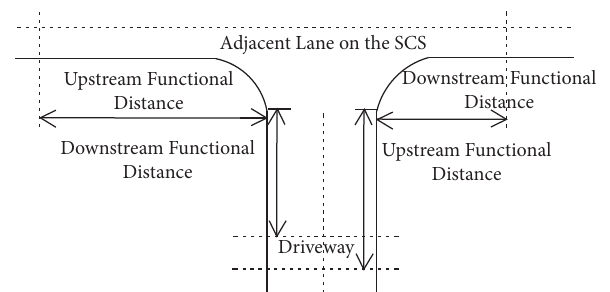
Figure 15: Functional area of the